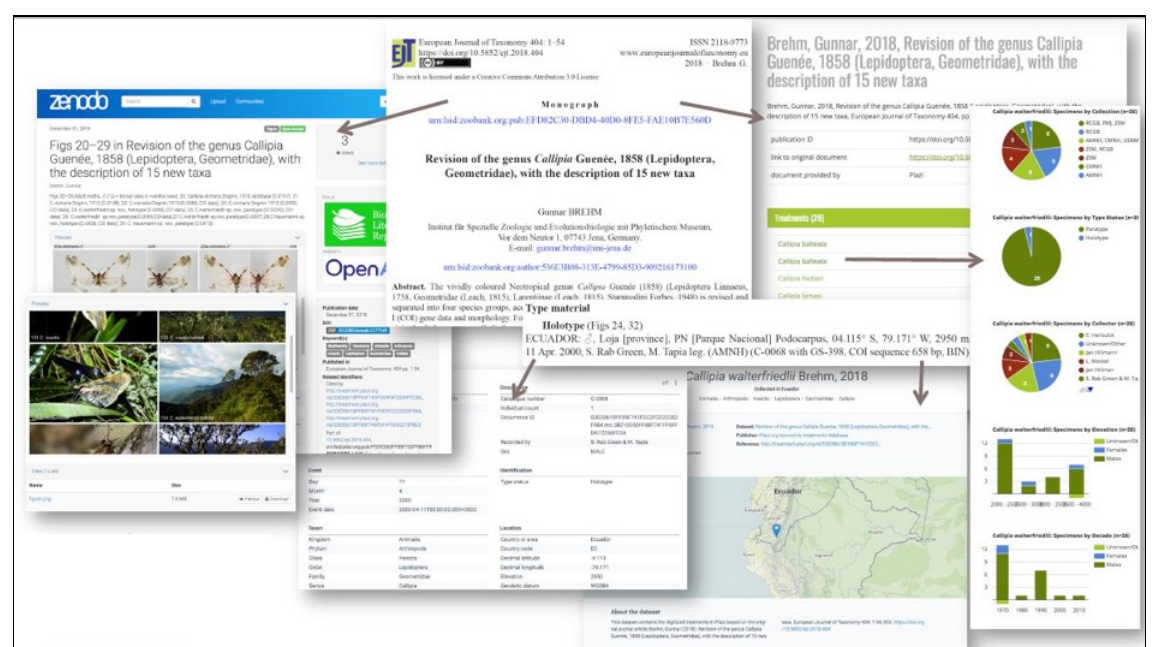
Fig. 2. The EJT -Plazi workflow. Plazi processes the PDF of an EJT publication to extract the sub- article elements and distribute them to biodiversity aggregators. Taxonomic treatments, images, tables, scientific names and even the fine-grain specimen data are semantically enhanced and available on a variety of platforms.